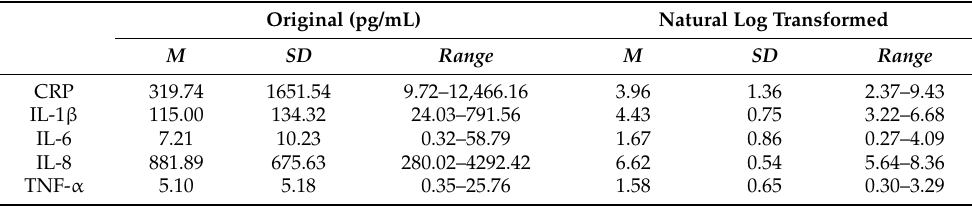
Figure 2. Histogram of acquired home radon concentrations ( a ) and of the computed radon exposure index ( b ). The left histogram is marked with the WHO and the US EPA action limits for indoor radon concentrations (at or above 2.7 and 4.0 pCi/L, respectively). The radon exposure index, calculated at the natural log of home radon concentrations multiplied by the amount of time the person has lived in their home (+1), is relatively normally distributed. Table 2. Descriptive statistics for each of the inflammatory markers (pg/mL) before and after natural log transformation.